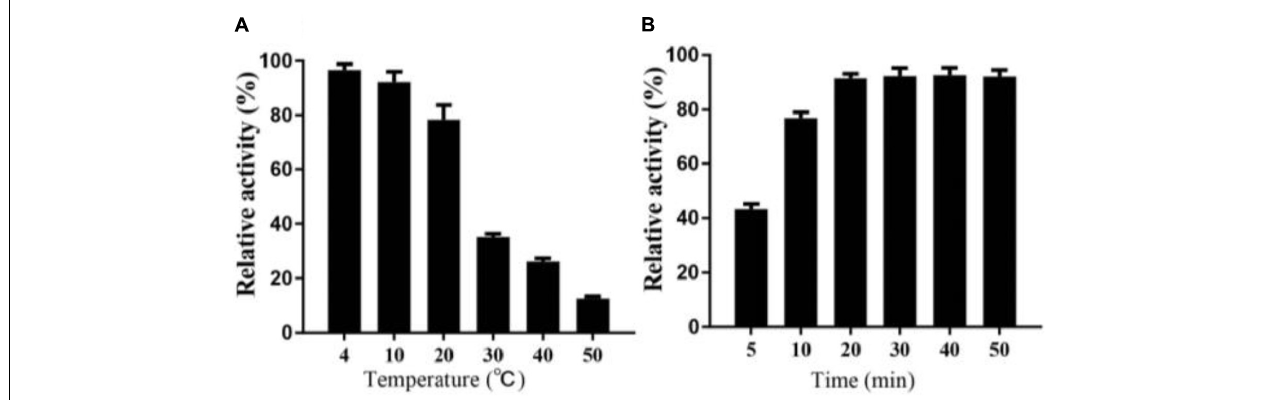
FIGURE 6 | Heat recovery analysis of Alyw203. (A) Determination of the optimum incubation temperature for restoring activity of Alyw203 after 5 min of heat treatment. (B) Influence of incubation time on activity recovery of heat-treated Alyw203 at 10 ◦ C. Values are expressed as mean ± SD, n = 3.